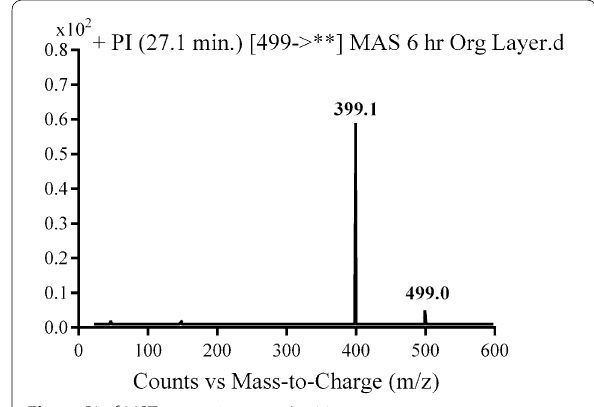
Fig. 4 PI of MST parent ion at m/z 499